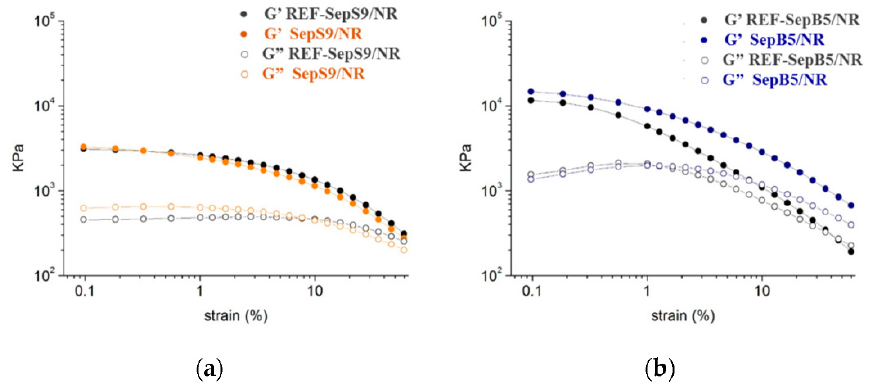
Figure 4. Strain dependency of elastic (G (cid:48) ) and viscous (G (cid:48)(cid:48) ) moduli for natural rubber silica/sepiolite nanocomposites from ref. [36]. ( a ) the trend of G (cid:48) for SepS9 and REF-SepS9. ( b ) the trend of G (cid:48) for SepB5 and